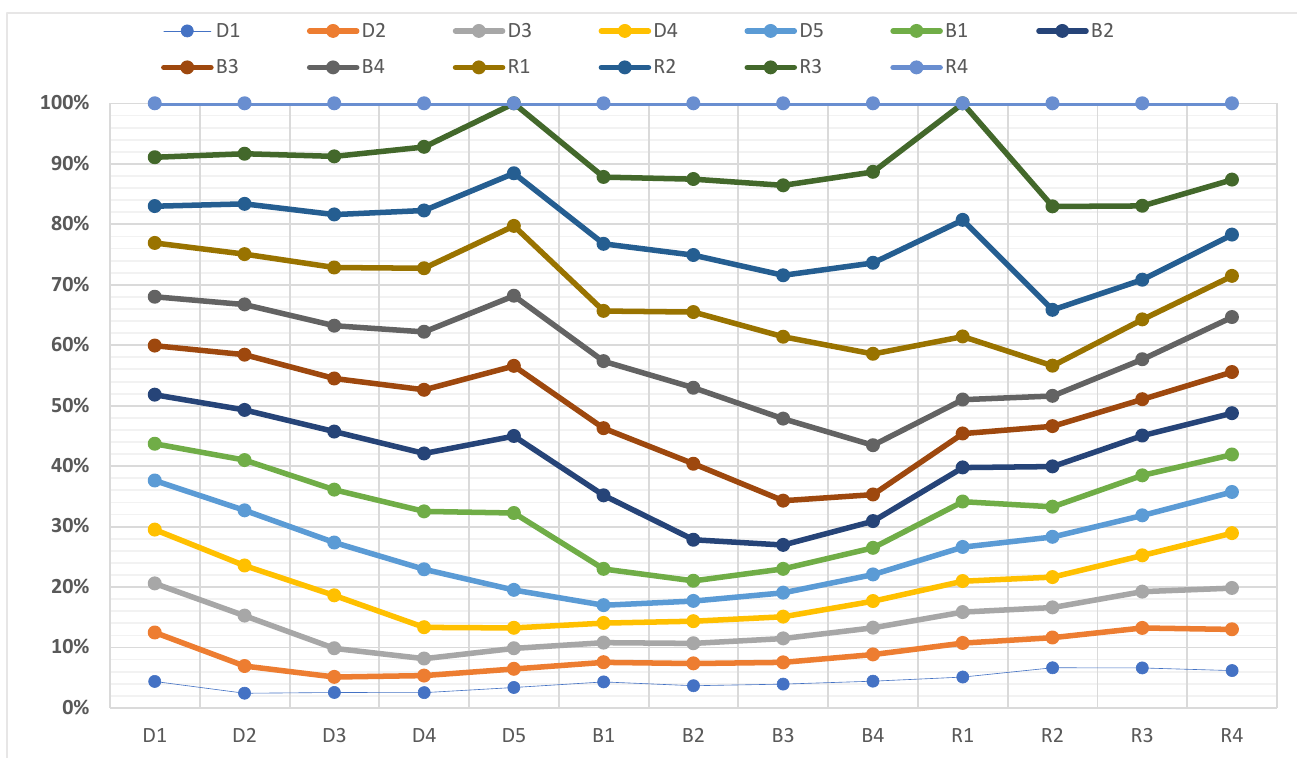
Figure 3. The graphical representation of initial experts’ perspectives.